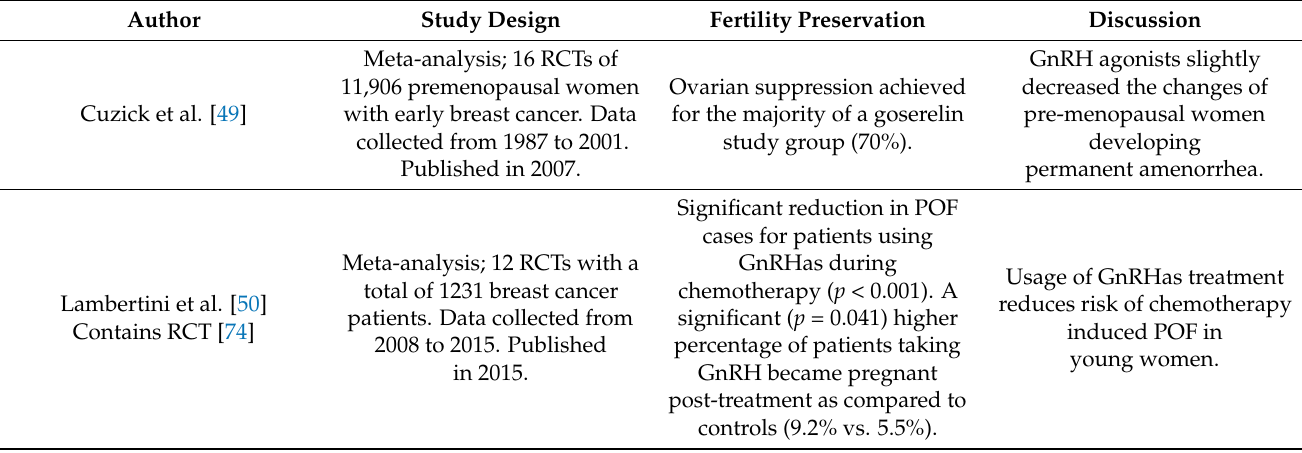
Table 2. Studies on GnRH agonists & fertility preservation post cancer